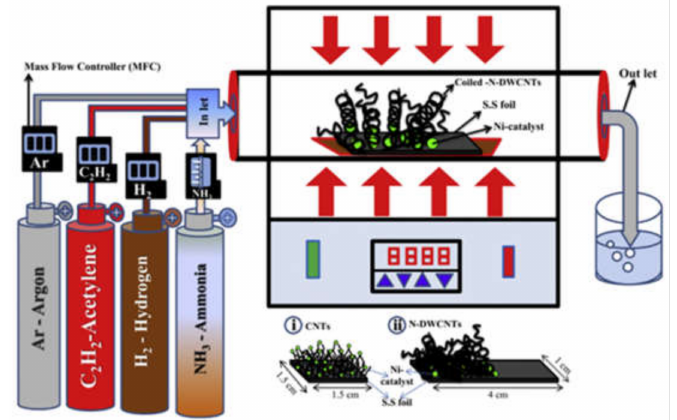
Figure 10. Chemical vapor deposition process for the preparation of CNTs and nitrogen-doped carbon nanotubes for supercapacitors. Reproduced with permission from [119]. Elsevier,